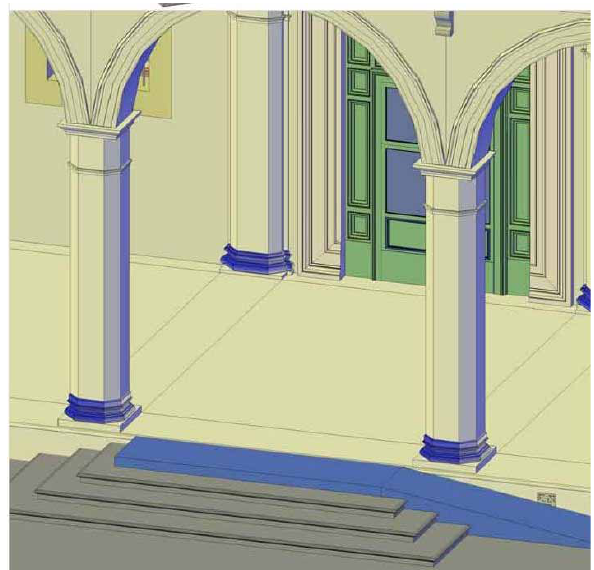
Figure 22. Detail view of the virtual model of the entrance of